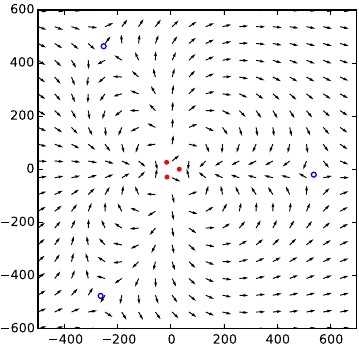
Figure 3. Configuration of a vortex-antivortex system for Q tip q e / H = 23 q 2 at T = 0 . 001 q 2 . Vortex (filled circles) and m m antivortex cores (open circles) are shown; arrows show magneti- zation. Coordinates are given in the units of lattice spacing a .